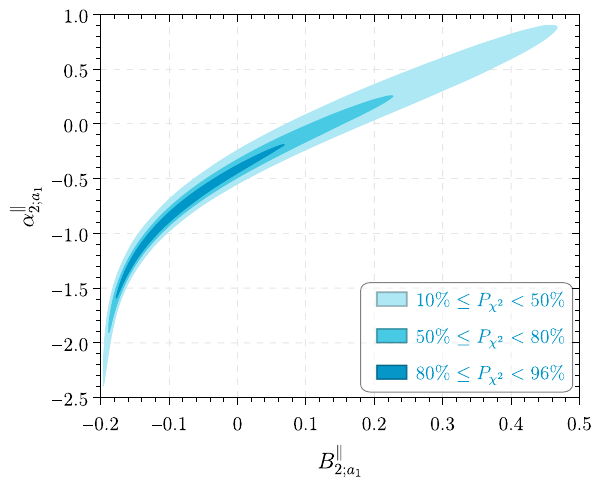
(cid:3) (cid:3) , B and 2 ; a 1 2 ; a 1